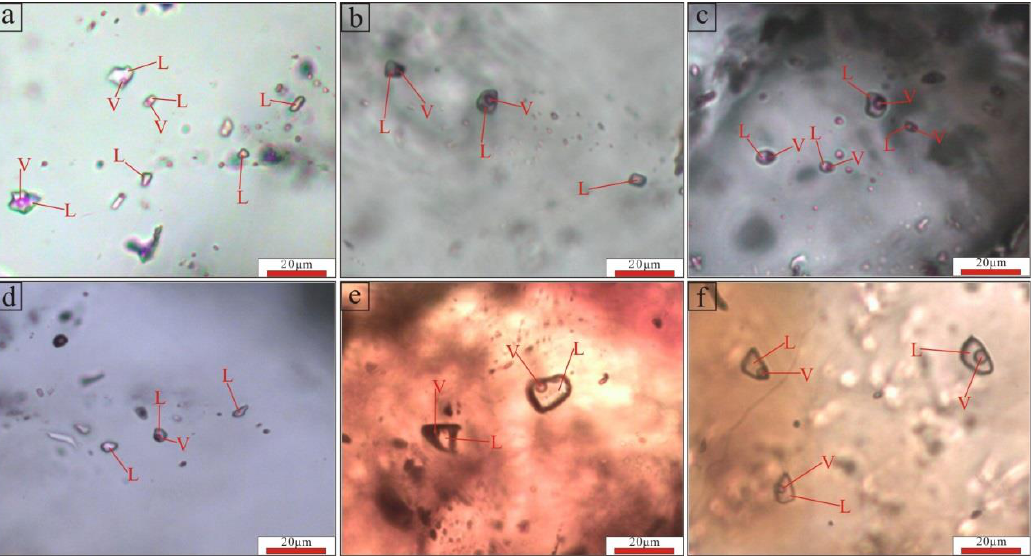
Figure 7. Photomicrographs of various types of fluid inclusions observed in the Changkeng – Fuwan Au ( a – c ) and Ag ( d – f ) deposit.